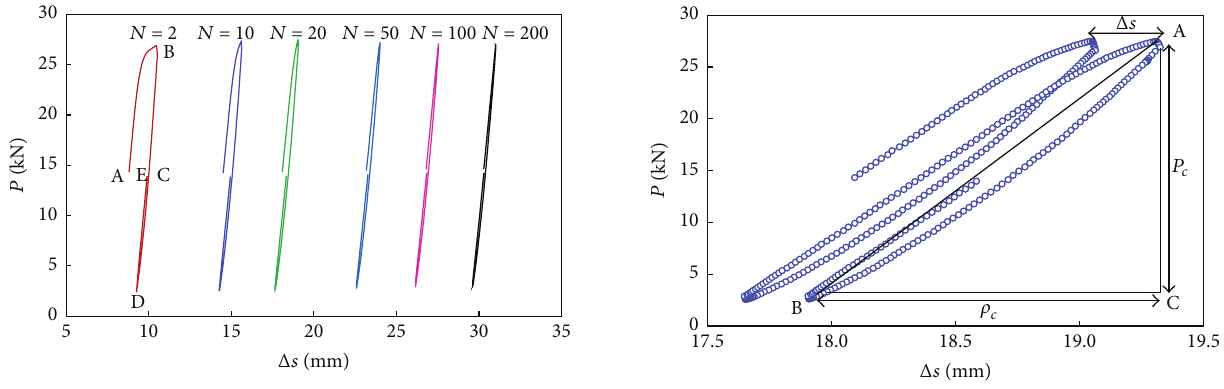
Figure 12: Load-settlement hysteresis loops for various values of N. Figure 13: Nonclosed load-settlement hysteresis